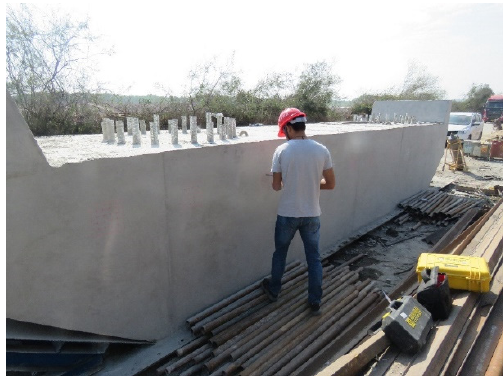
Figure 7. The concrete strength monitoring test of a prefabricated cap beam using a digital display rebound instrument.